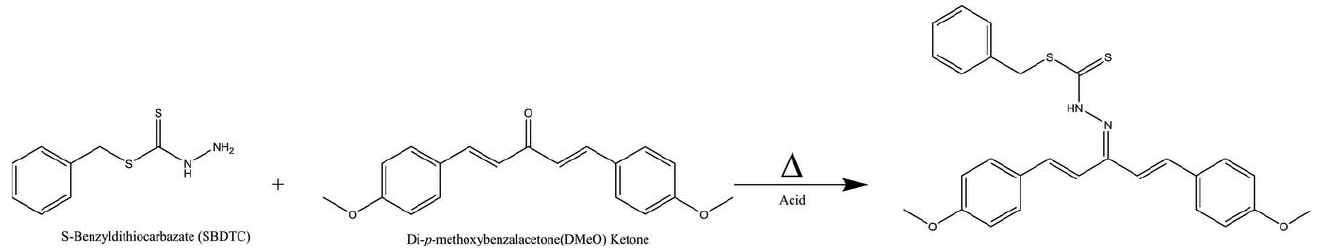
Figure 7 Reaction scheme for the synthesis of ( I